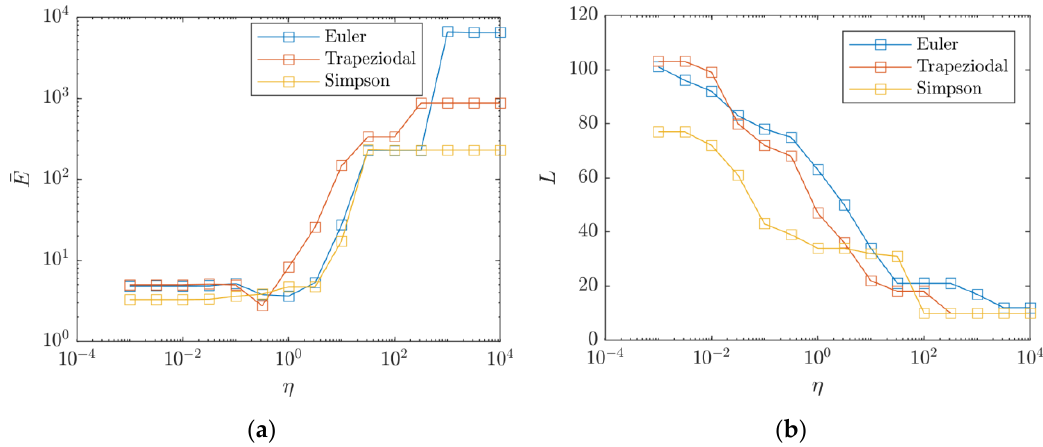
Figure 9. Results of the reconstruction of system Equations in (39) using integration of orders 1, 2 and 4 (Euler, Trapezoidal and Simpson’s respectively) in accordance to the delMinorTerms tolerance. ( a ) Mean error E by 4 dimensions; ( b ) overall number of terms L in the reconstruction, where L = 8 corresponds to the original system Equations in (39). We tested 15 values of η , 10 experiments were carried out with each value.